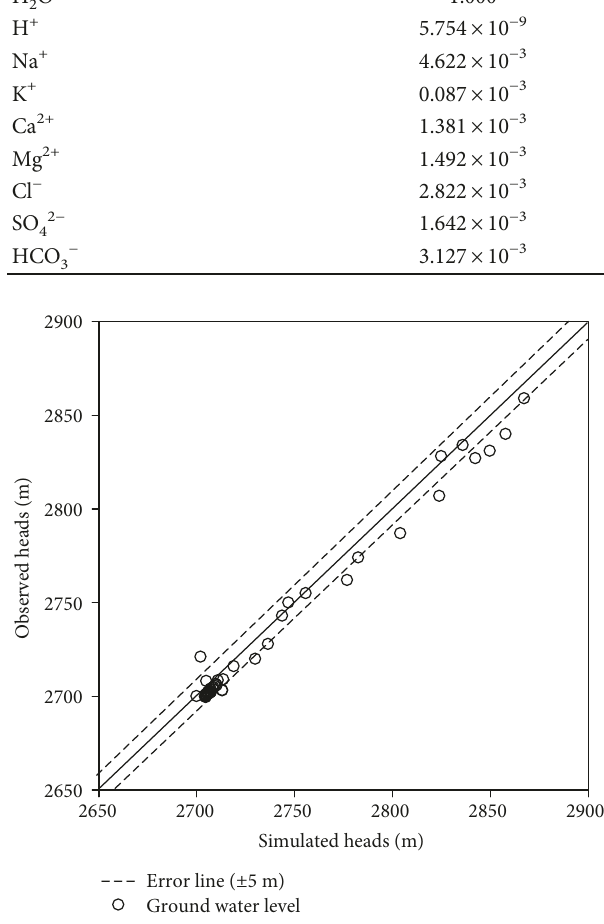
Figure 5: Comparison of the simulated groundwater heads with the observed heads.